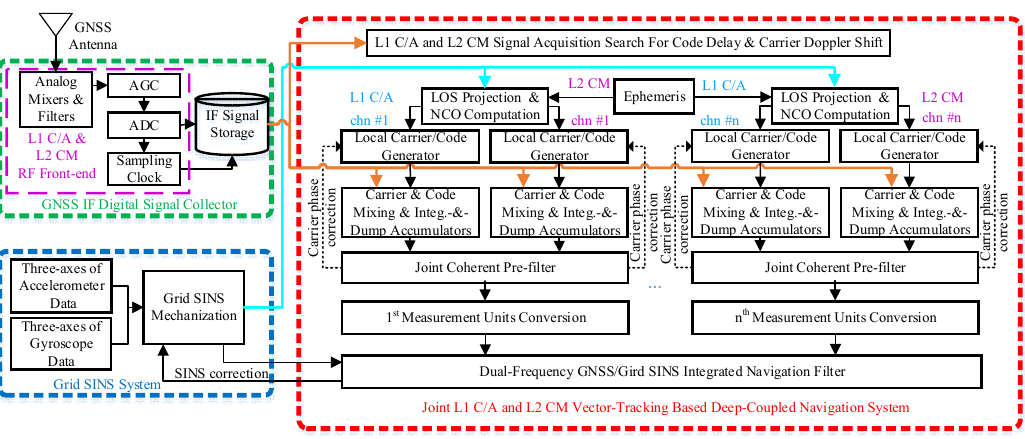
Figure 2. Block diagram of joint L1 C/A and L2 CM vector-tracking-based global navigation satellite system (GNSS)/strapdown inertial navigation system (SINS) deep-coupled navigation system structure.